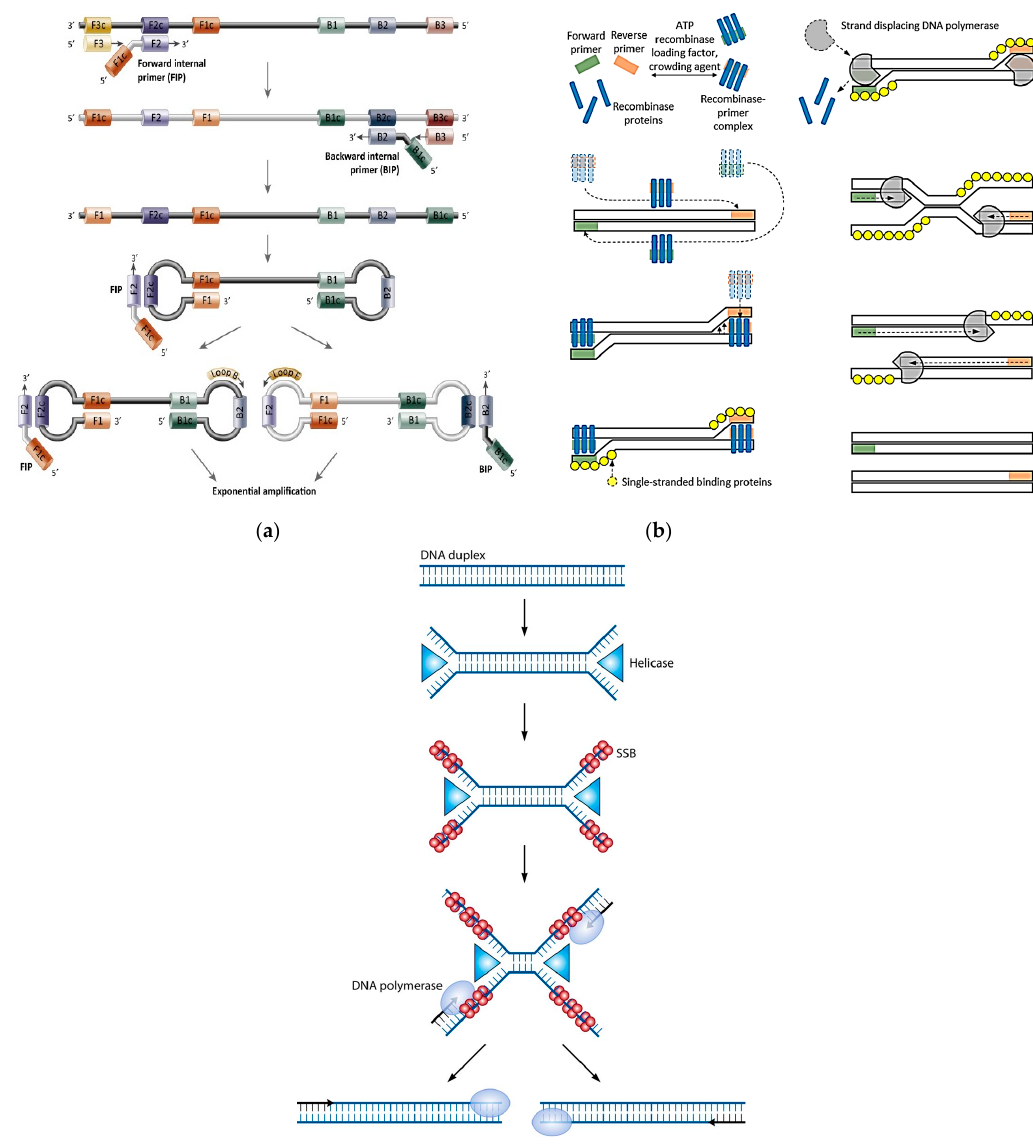
Figure 4. Isothermal approaches for NATs. ( a ) Loop-Mediated Isothermal Amplification. Reproduced with permission from [43]. Copyright 2021, Elsevier. ( b ) Recombinase Polymerase Amplification. Adapted with permission from [44]. Cop- yright 2021, Elsevier. ( c ) Helicase-Dependent Amplification. Reproduced with permission from [45]. Copyright 2021, American Society for Microbiology—Journals.